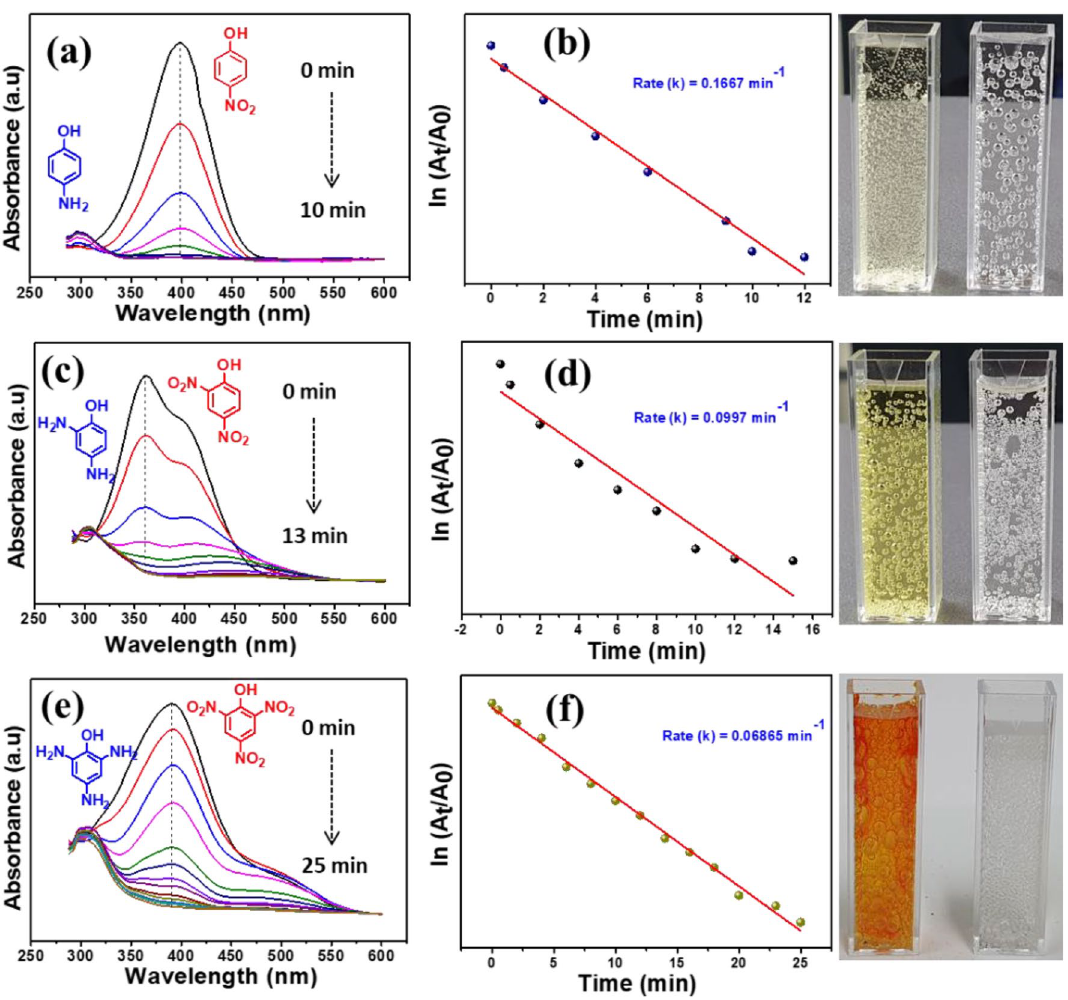
Figure 8. Catalytic activity and kinetic rate of PdO–NiO nanocomposite on reduction of nitrophenols with NaBH 4 solution ( a , b ) NP, ( c , d ) DNP and ( e , f )